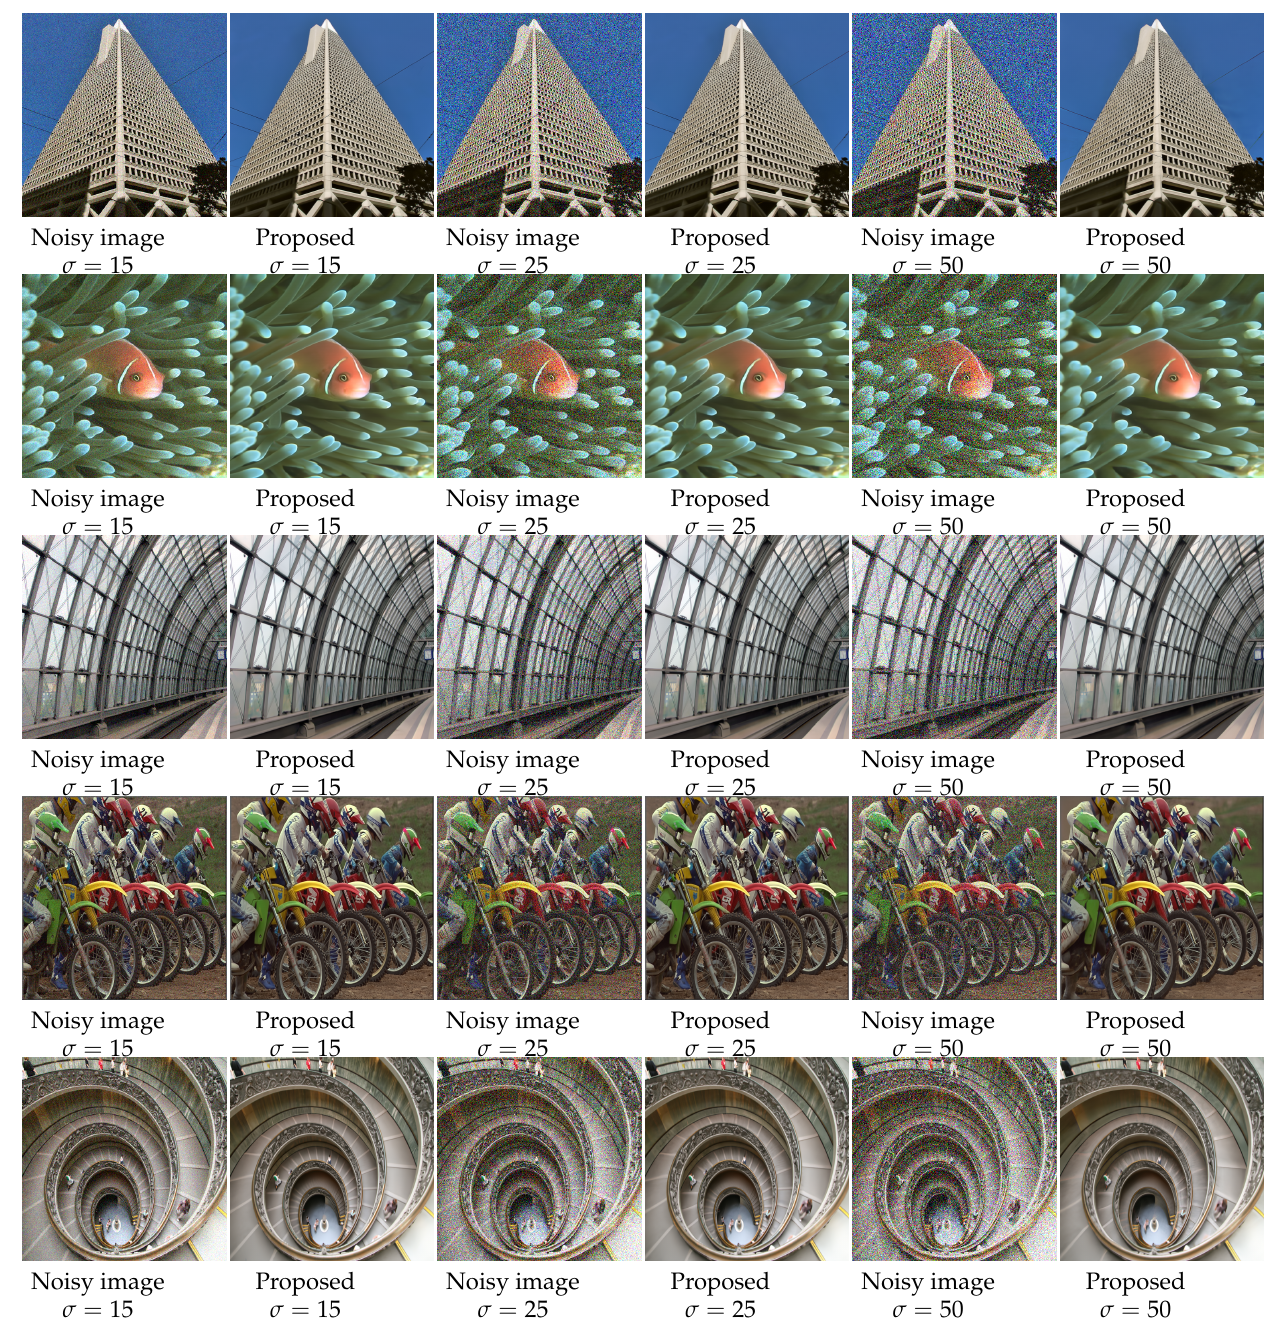
Figure 10. Sample results for different datasets for σ = 15, 25, and 50 (for best view, zooming in is